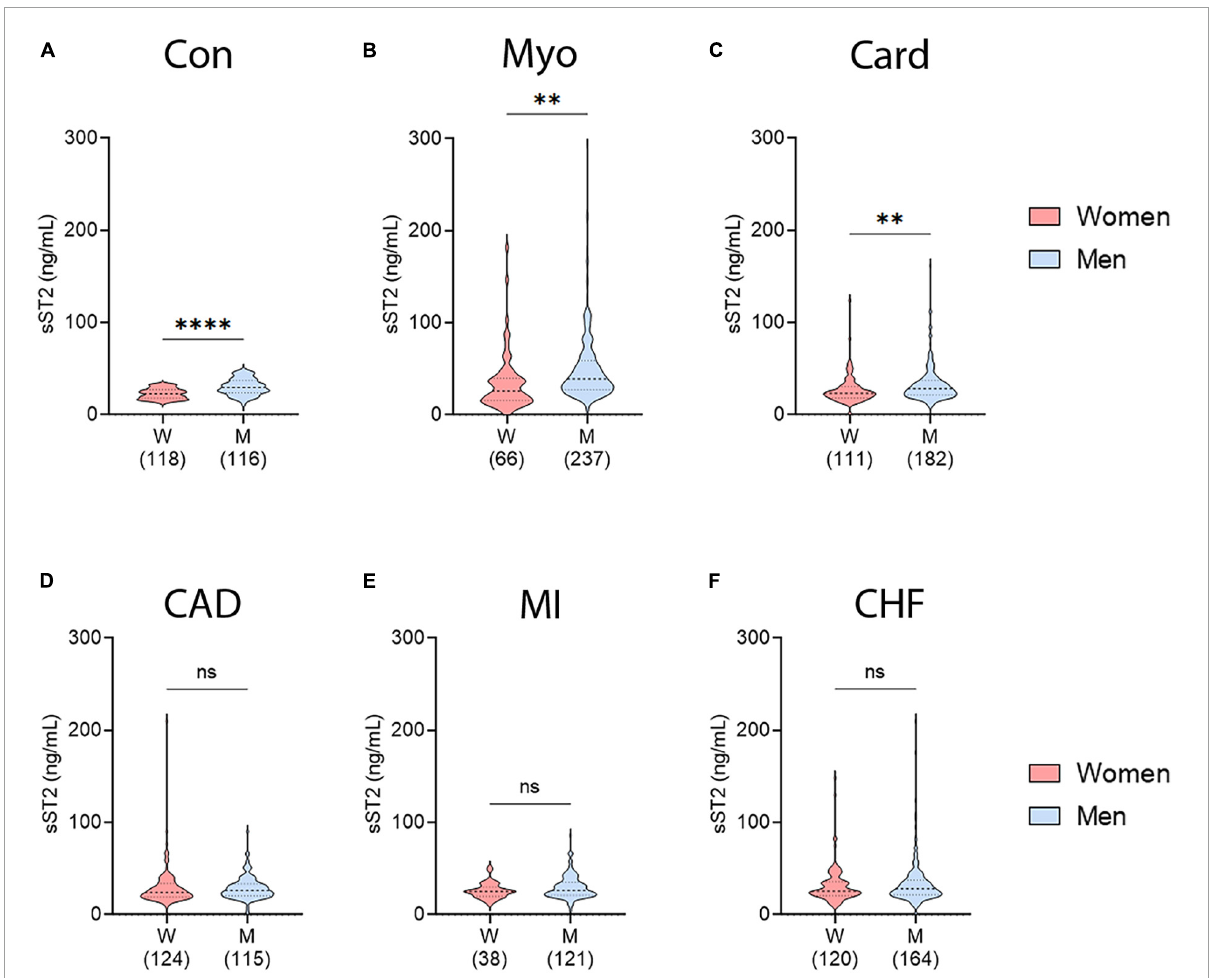
FIGURE2 Sex differences in sST2 in controls and CVDs. sST2 levels compared women (peach) vs. men (blue) for (A) controls, (B) myocarditis (Myo), (C) cardiomyopathy (Card), (D) coronary artery disease (CAD), (E) myocardial infarction (MI), or (F) congestive heart failure (CHF). Violin plots denote data distribution for each group with p- value calculated using unpaired Student’s t -test: ∗∗ , p < 0.01; ∗∗∗∗ , p < 0.0001; ns, not